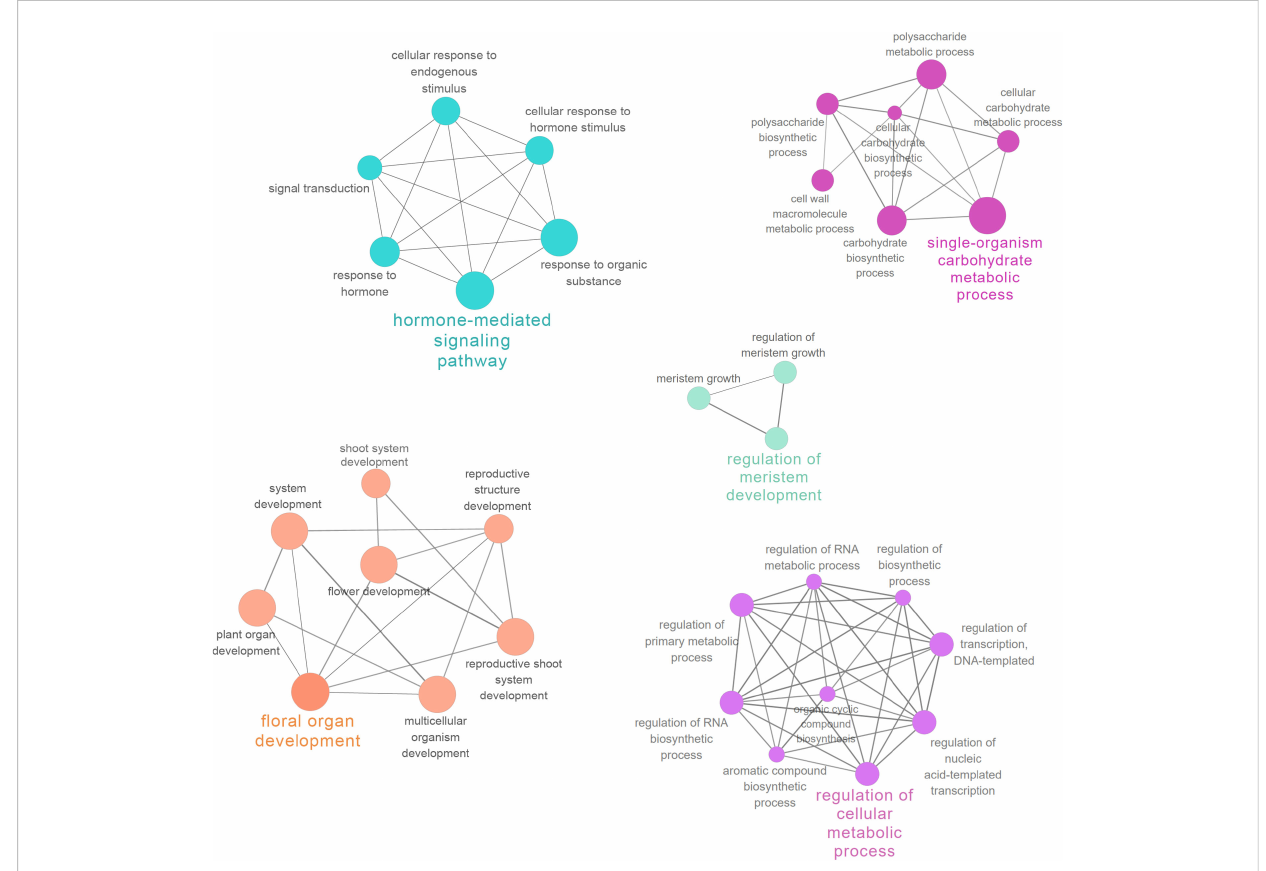
FIGURE 5 Functional enrichment analysis of PPI network. Important functionally grouped networks are shown in different